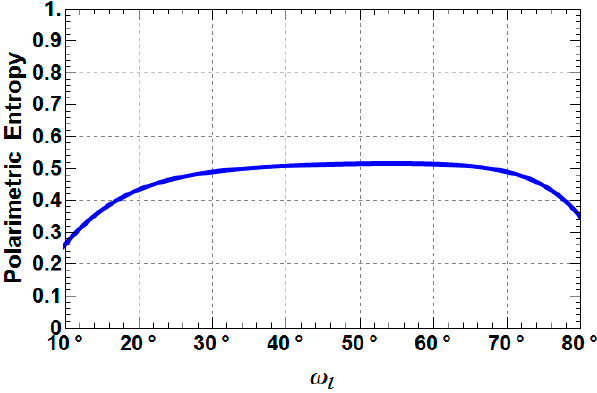
Figure 8. Sensitivity of polarimetric entropy H with local incidence angle ω 1 ( ε s = 20, ε t = 10, L SXD = 1, ϕ = 0°, θ 1 = 30°).